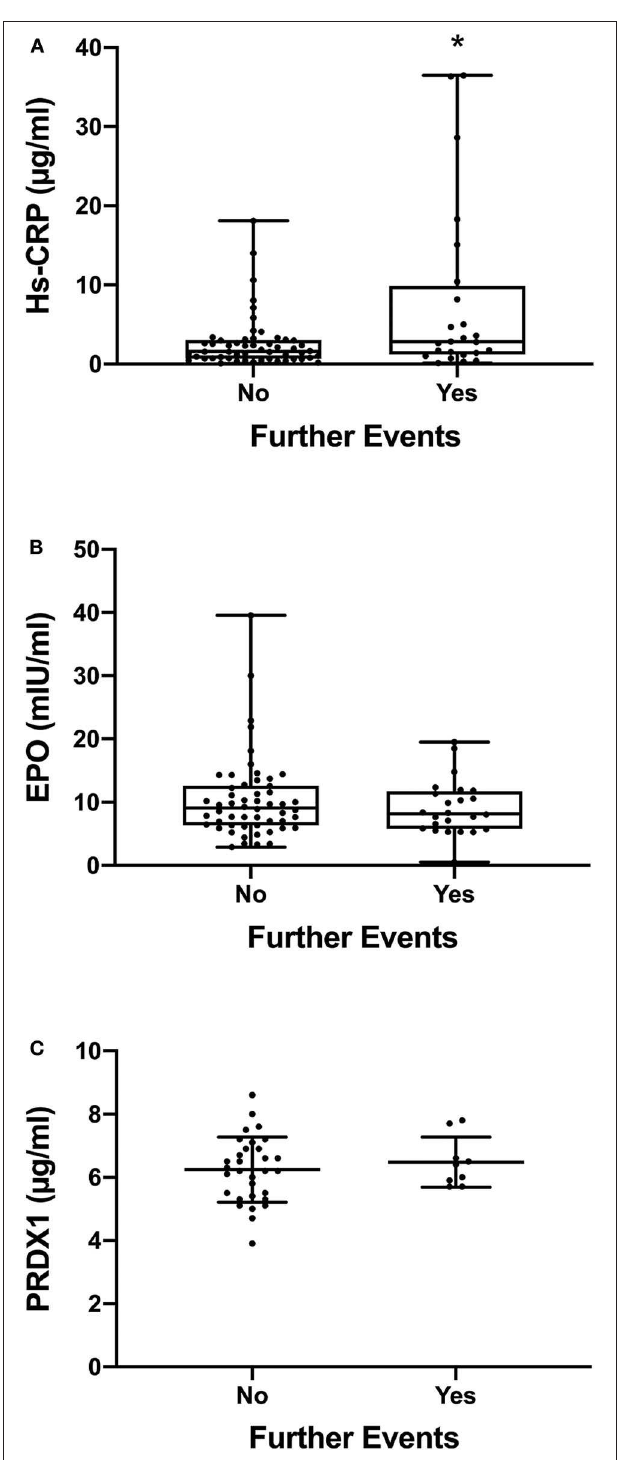
FIGURE 1 | CRP, EPO, and PRDX1 levels in patients. Since the plasma levels of hs-CRP and EPO are not normally distributed, the data in (A,B) are presented as box and whiskers plot (minimum, 1st quartile, median, 3rd quartile, maximum); n = 54 for the group with no further events and n = 24 for the group with further events. The plasma levels of PRDX1 are normally distributed and therefore the data in (C) are presented as mean ± SD; n = 31